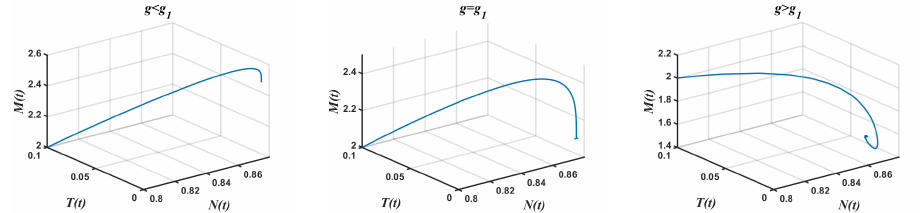
Figure 7. Parametric solutions of model (1) for various g values corresponding to Figure 5.